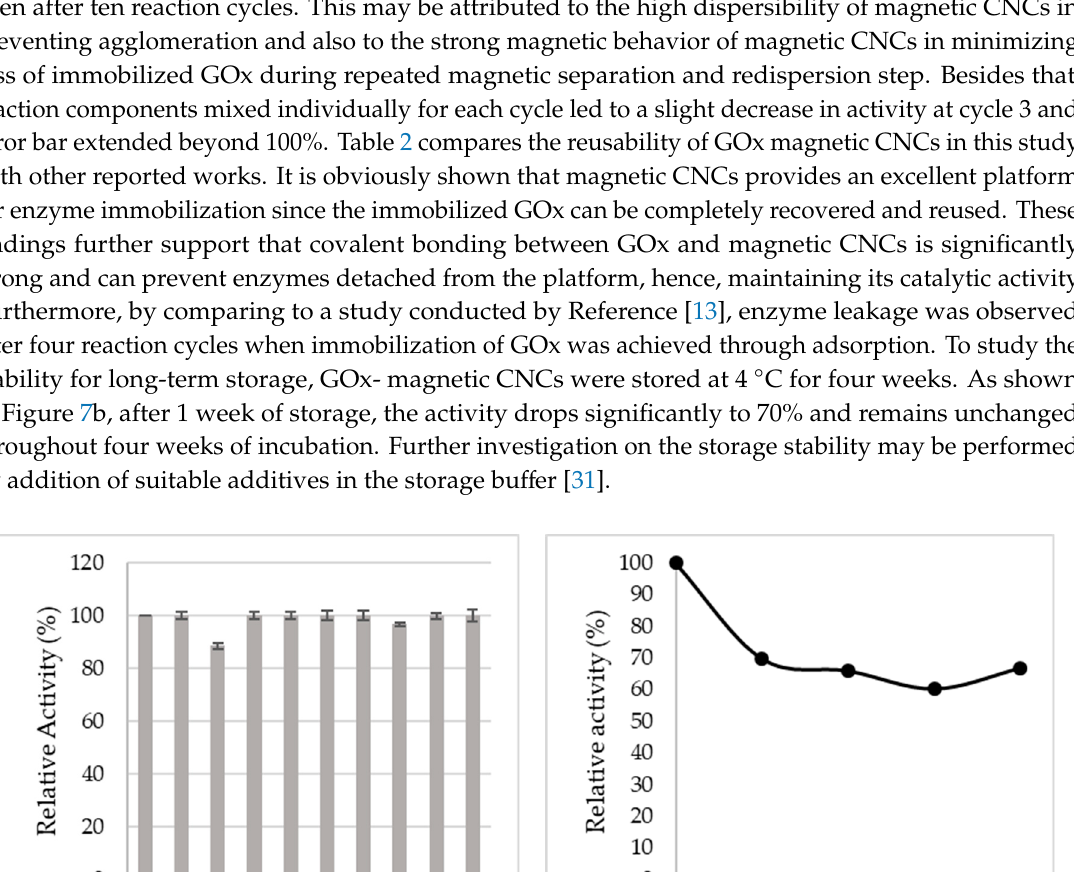
Figure 6. Specificity test of immobilized GOx using glucose (1.25 mM), maltose (1.25 mM), sucrose (1.25 mM), and fructose (1.25 mM).